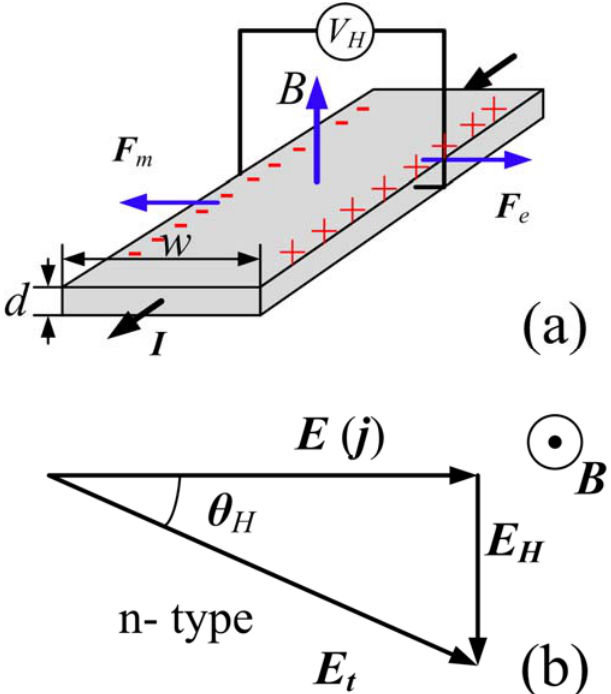
Figure 1. ( a ) Sketch of an n-type semiconductor exposed to a constant magnetic field, B , perpendicular to the surface. Applying a constant current I will cause an accumulation of charge carriers, transverse to the current direction and a Hall voltage, V . F and F H m e indicate magnetic force and electric force, respectively. Note, the direction of the current I in the diagram is that of a conventional current; hence, the motion of electrons is in the opposite direction; ( b ) Hall electric field E generated in an n-type conductor at field B . H The symbol j is the current density; θ is the Hall angle indicating the difference between H the total electric field and the external electric